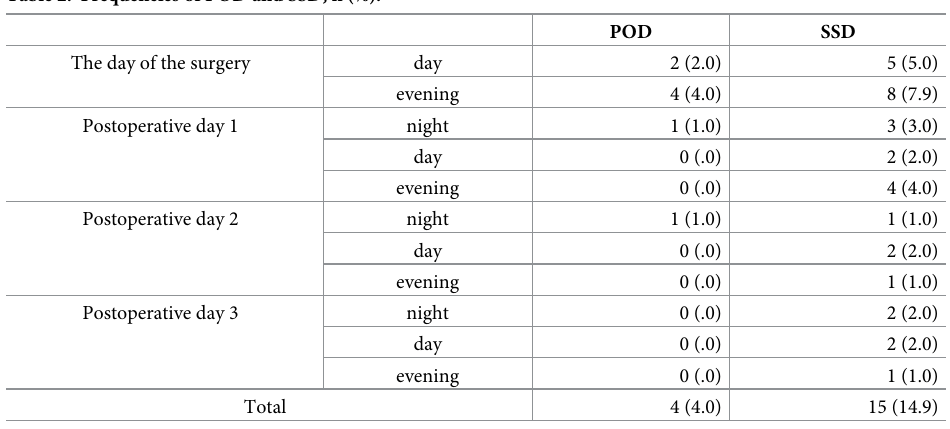
Table 2. Frequencies of POD and SSD, n